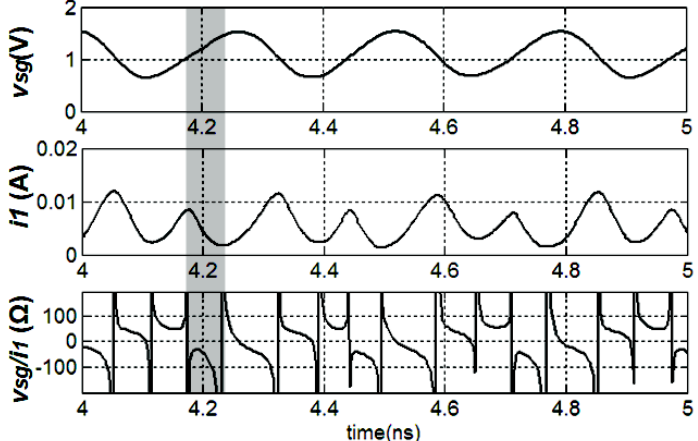
Figure 5. ( a ) The proposed LC resonant loads with passive negative resistance (PNR); ( b ) The I-V curve of M3 / M4 .